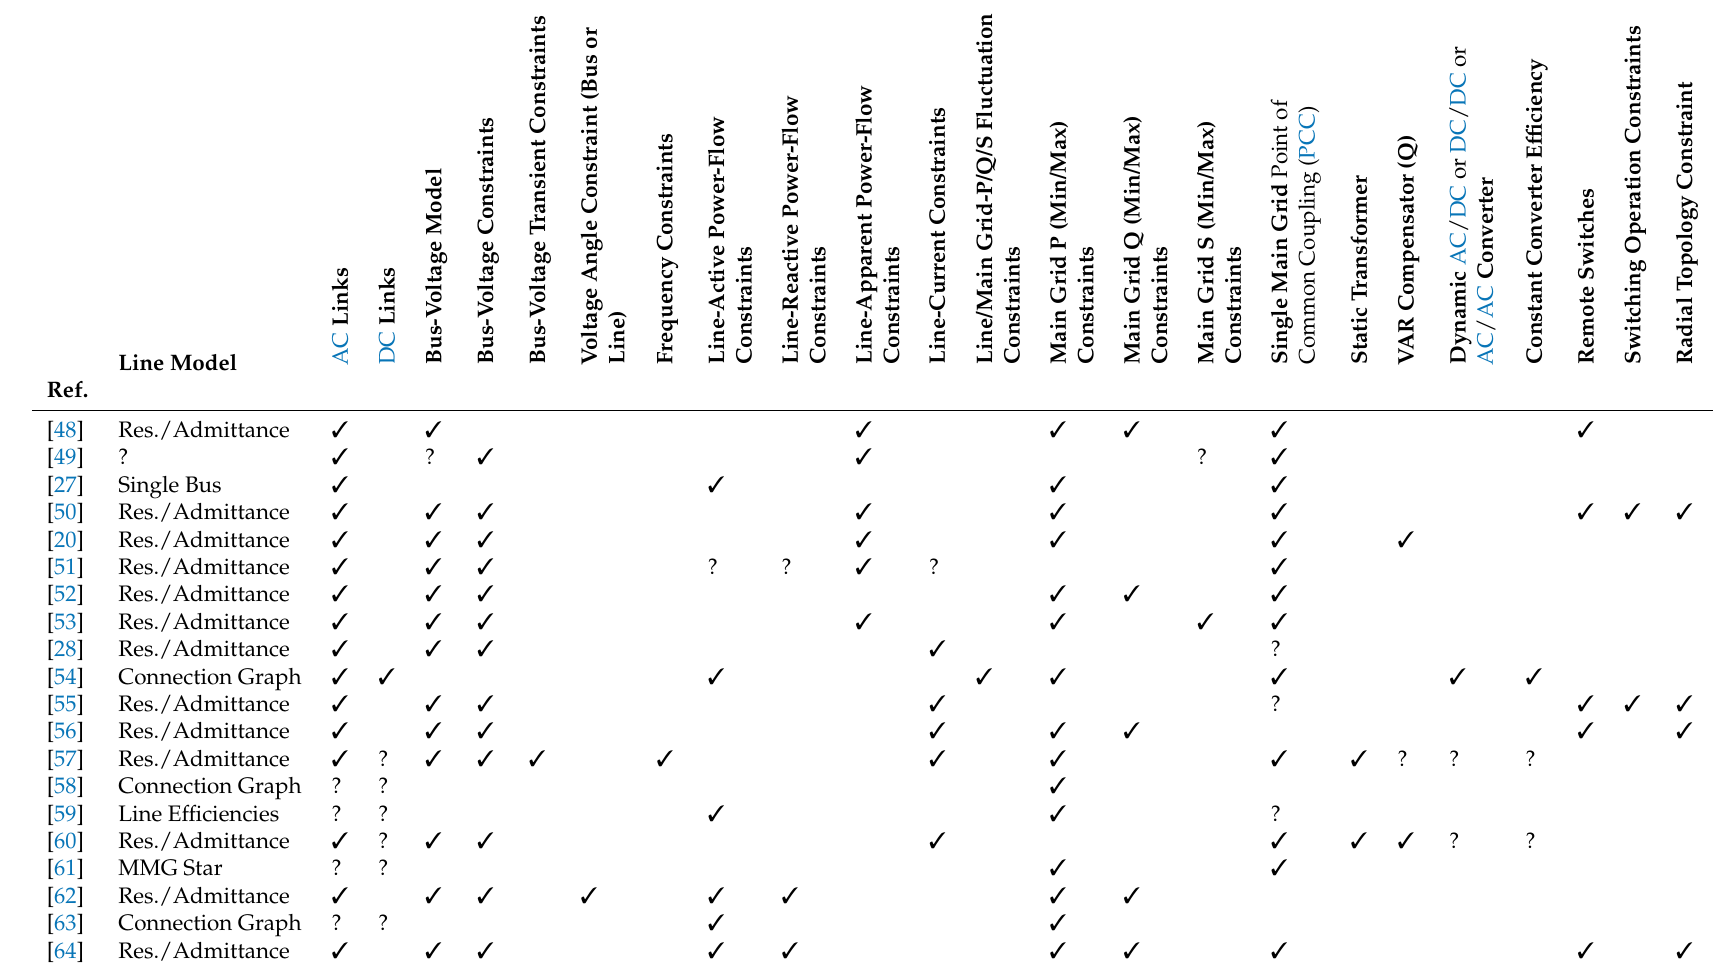
Table 4. Grid model ( (cid:51) : Implemented, ?: Not reported)